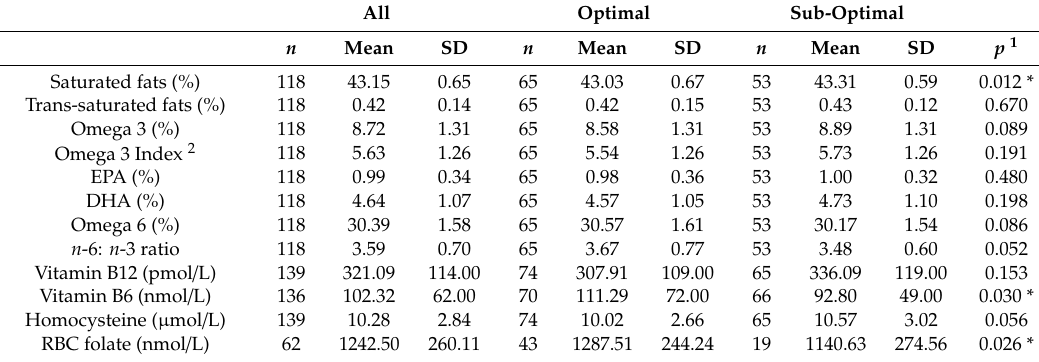
Table 3. Biochemical markers for all participants and by diet quality group.